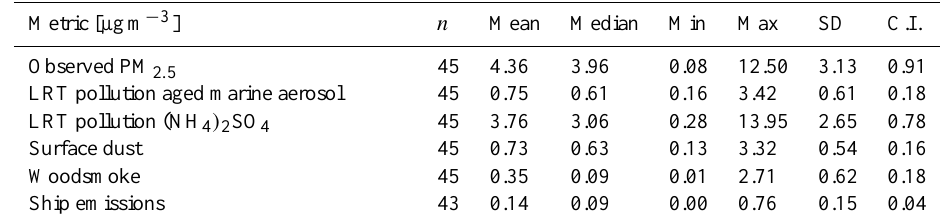
Table 3. Absolute principal component scores PM 2 . 5 source apportionment descriptive